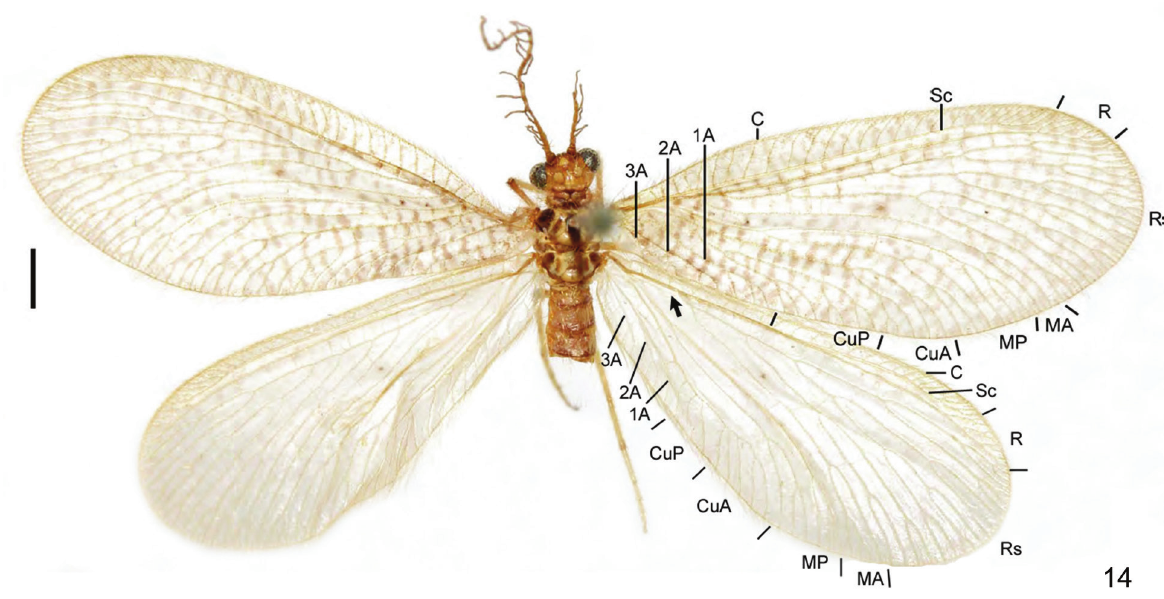
Figure 14. Dilar anatolicus sp. n., holotype, male (HUAC, Vienna), habitus. Arrow indicates base of hindwing MA vein. Scale bar = 1.0 mm.